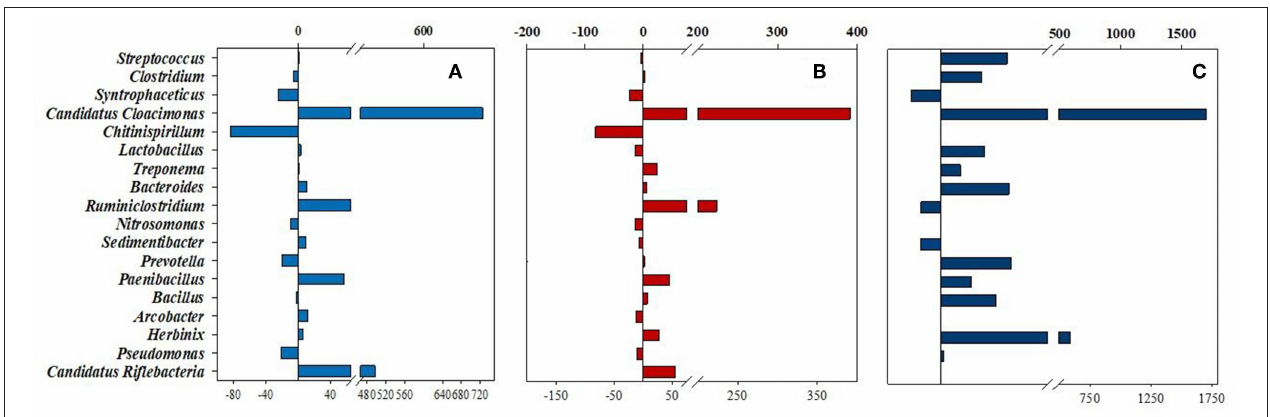
FIGURE 5 | Percentile changes of Bacteria relative abundances at genus level. The 18 genera, which were detected in > 1% abundance. The changes between the reactors supplied with daily H 2 dose and their counterparts, flushed with N 2 , are compared. (A) Light blue = CH-CN, (B) Red = SH-SN, and (C) Dark blue = CHw12-CNw12,